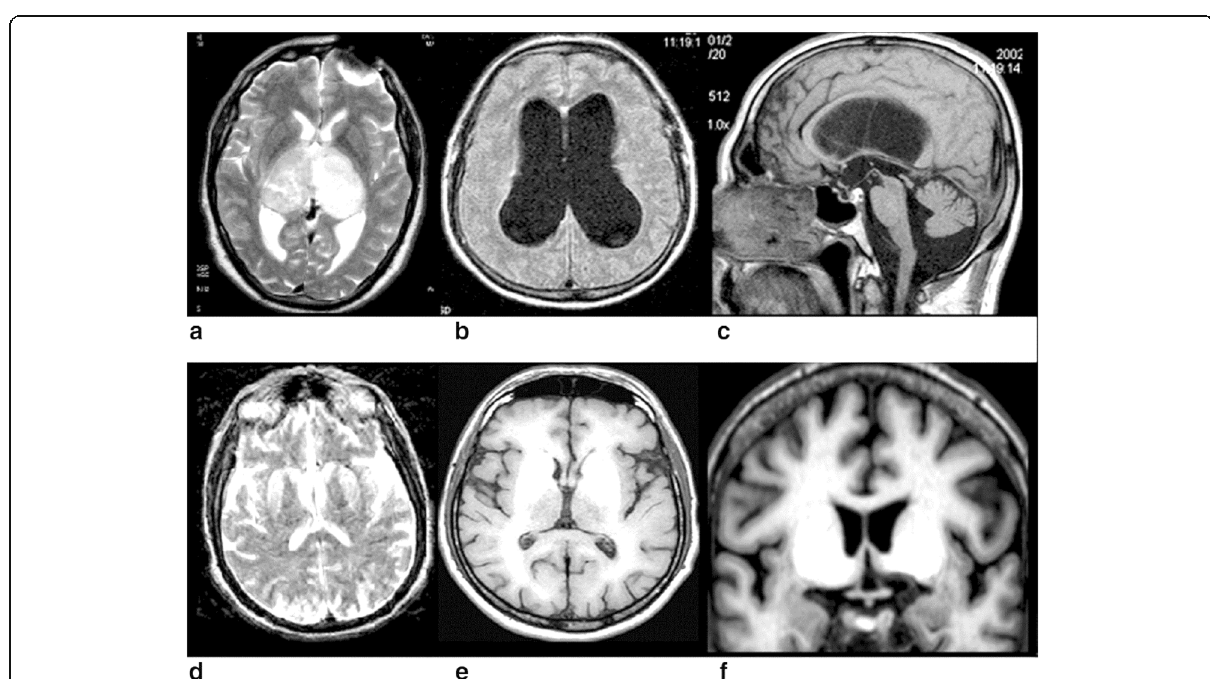
Fig. 1 MRI of nondegenerative “ symptomatic ” causes of parkinsonism. a Bilateral thalamic grade II glioma. Axial T2-weighted turbo spin echo MR image reveals two hyperintense mass lesions in the thalami. b Axial T2-weighted FLAIR MR image shows marked dilatation of the lateral ventricles exhibiting a ballooned shape and effacement of the cortical sulci. c Sagittal T 1 spin echo MR image confirms the dilatation of the lateral ventricle and reveals dilatation of the cerebral aqueduct and fourth ventricle. Note the bowing of the corpus callosum and the effacement of the cortical sulci. Both cases in b and c images have normal pressure hydrocephalus. d Creutzfeldt-Jakob disease. Axial T 2 -weighted MR image shows symmetric hyperintensity of the putamen and head of caudate. e Axial T 1 -weighted spin echo and coronal T 1 -weighted gradient echo. f MR images show marked symmetric hyperintensity of the globus pallidus, putamen, and caudate